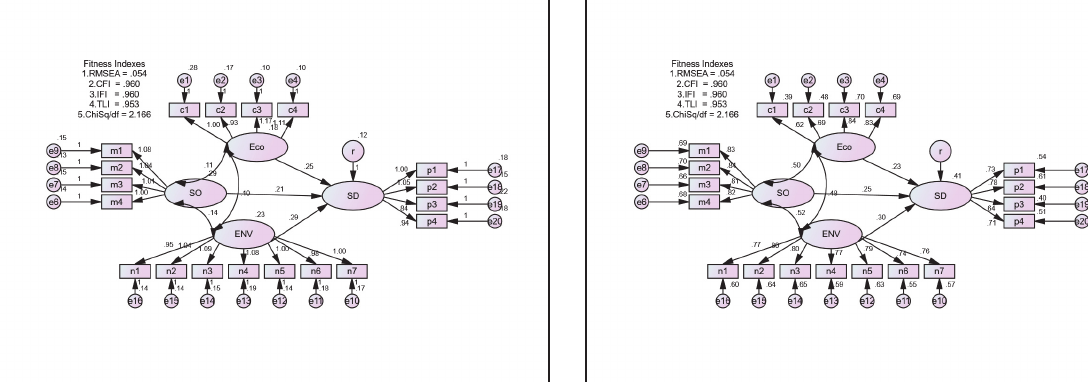
Fig. 3. unstandardized estimates Fig. 4. standardized estimates The Regression Weights Estimate S.E. C.R. P Label .251 .070